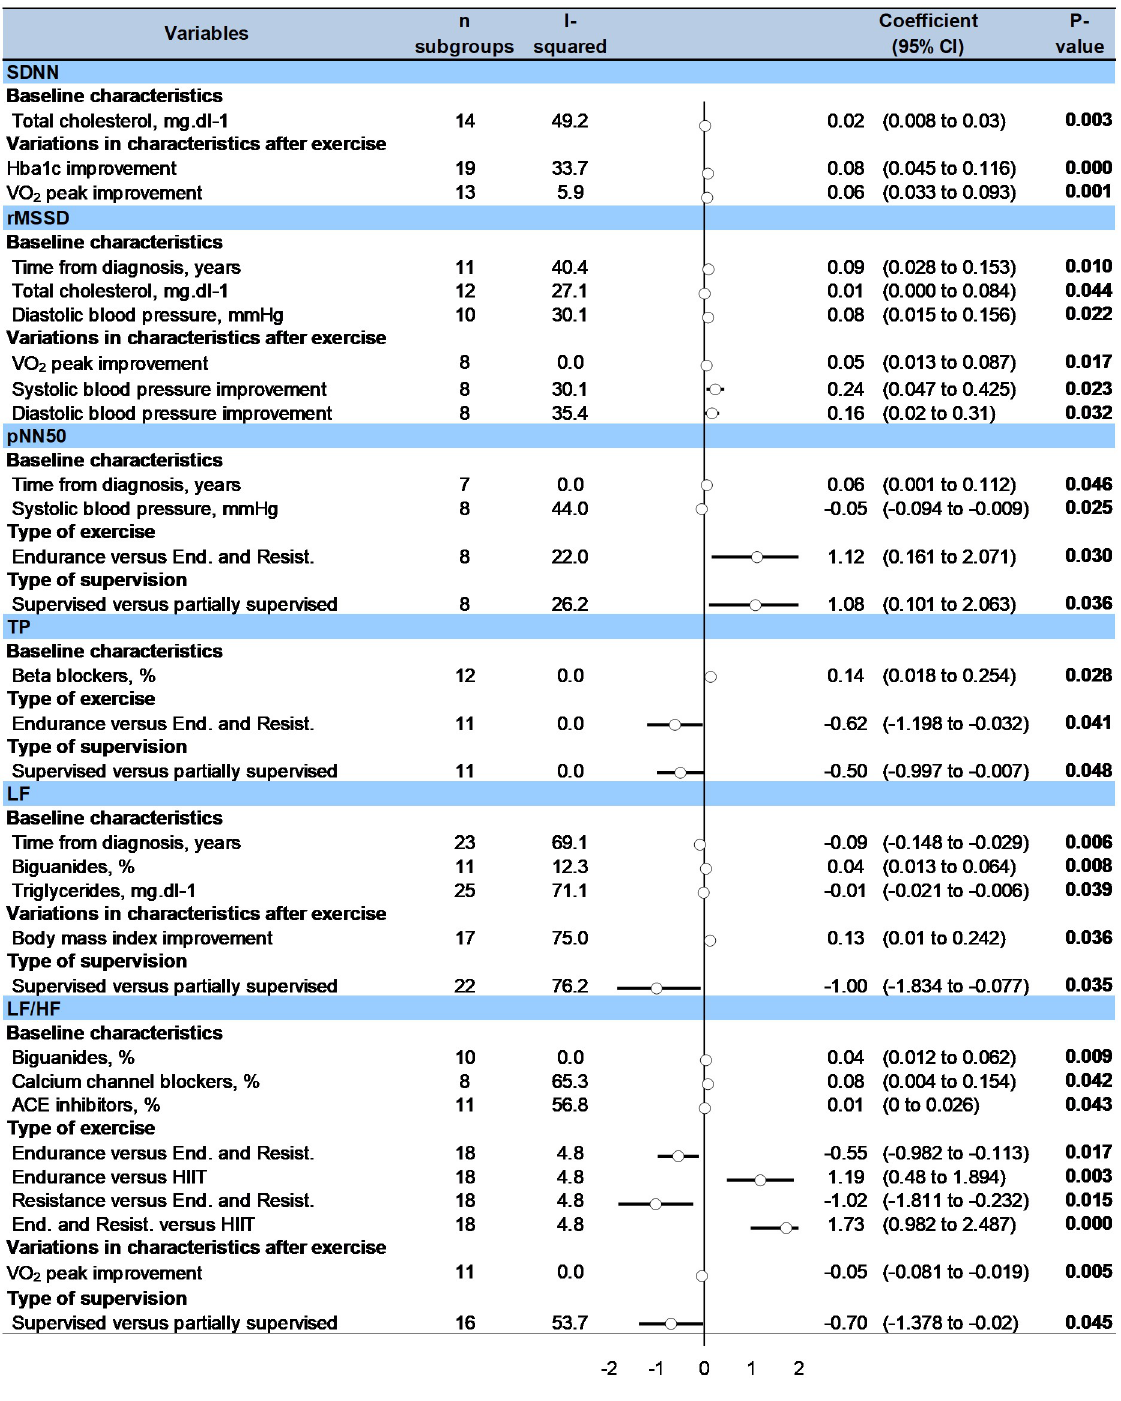
PLOS ONE | https://doi.org/10.1371/journal.pone.0251863 May 17,